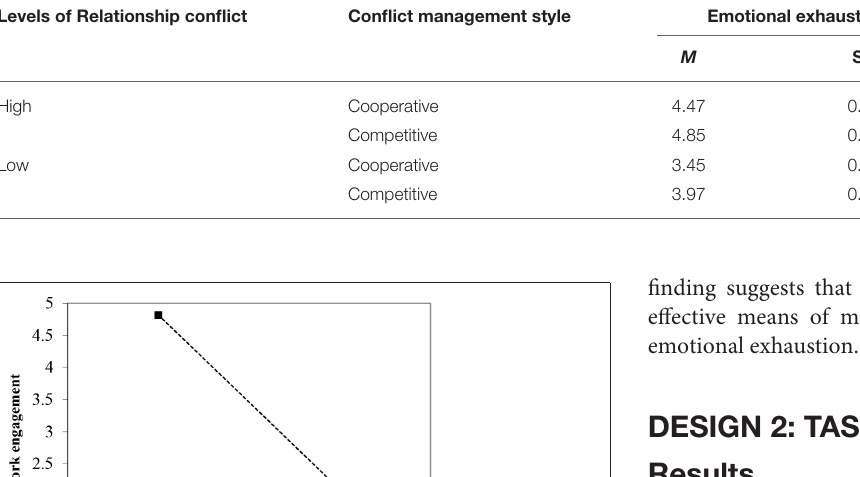
TABLE 3 | Descriptive statistics according to the conditions for work engagement and emotional exhaustion ( N = 60). Levels of Relationship